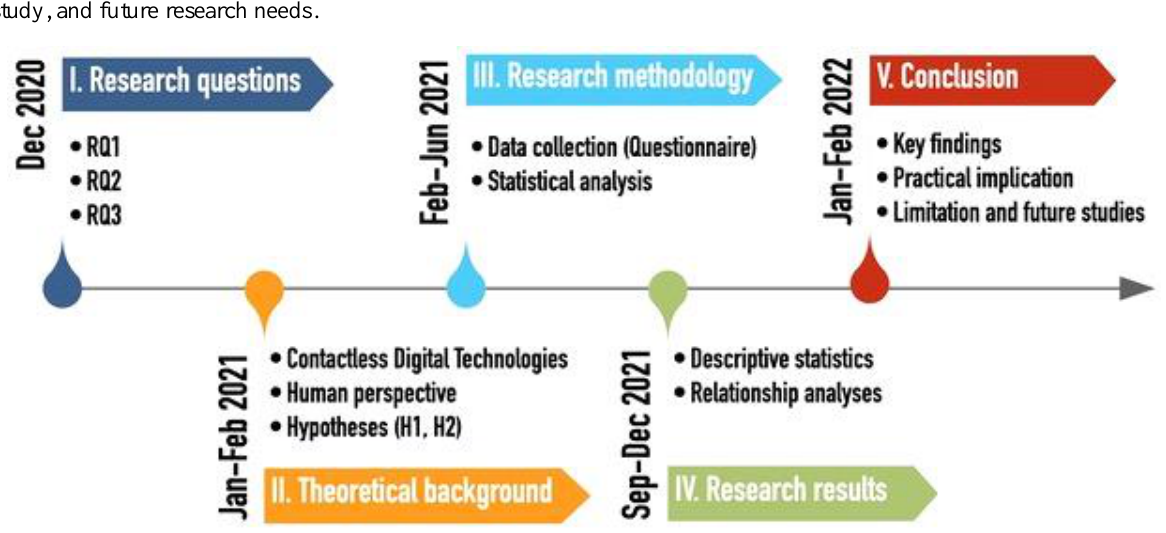
Figure 1. Flowchart of the research